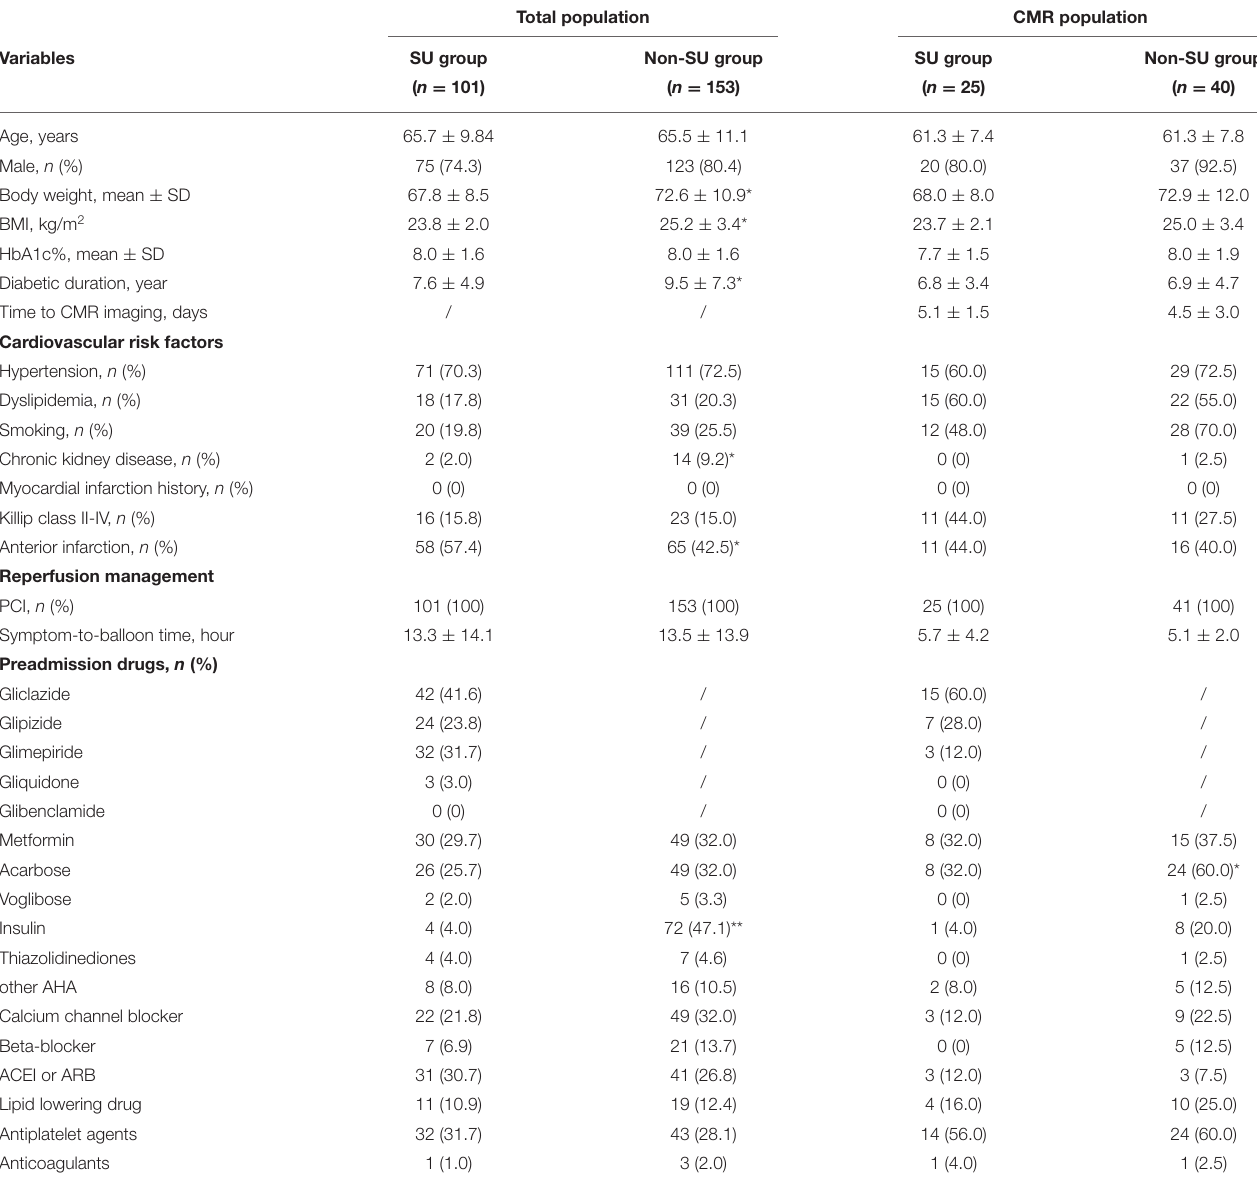
TABLE 1 | Baseline characteristics of total population and CMR